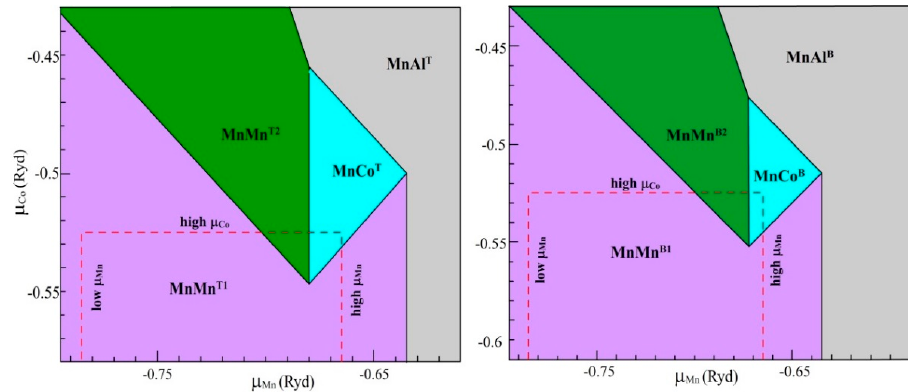
Figure 4. The calculated phase diagram of the Mn 2 CoAl/Ag/Mn 2 CoAl (001) interface. The dashed lines denote the thermodynamically accessible region.